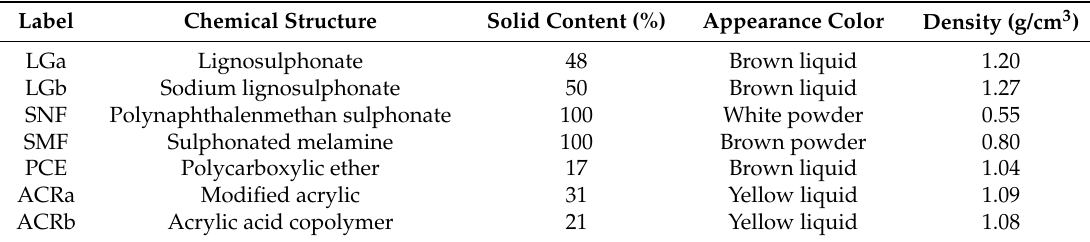
Table 2. Chemical and physical properties of the investigated